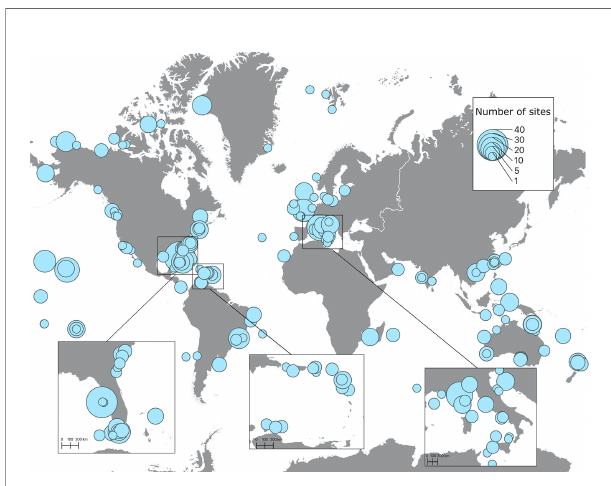
FIGURE 3 | Spatial distributions of recordings extracted from published studies on ocean soundscapes (see Supplementary Material for data sources) recorded between 0 and 50 m depth. Points on the map represent areas where underwater recordings were made, with the size of the point being proportional to the number of sites of each